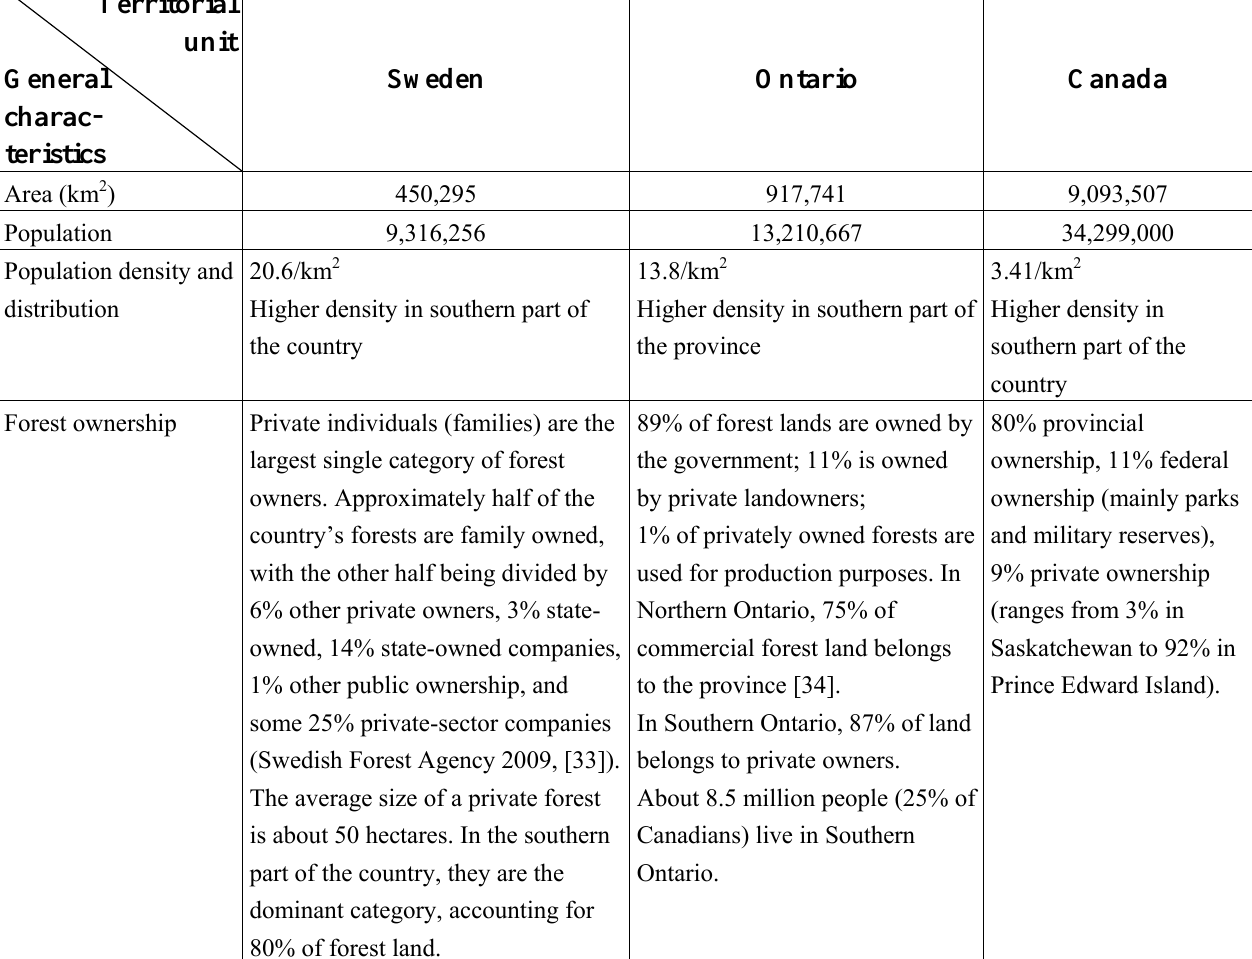
Table 1. General characteristics of territorial units (based on [32] unless stated